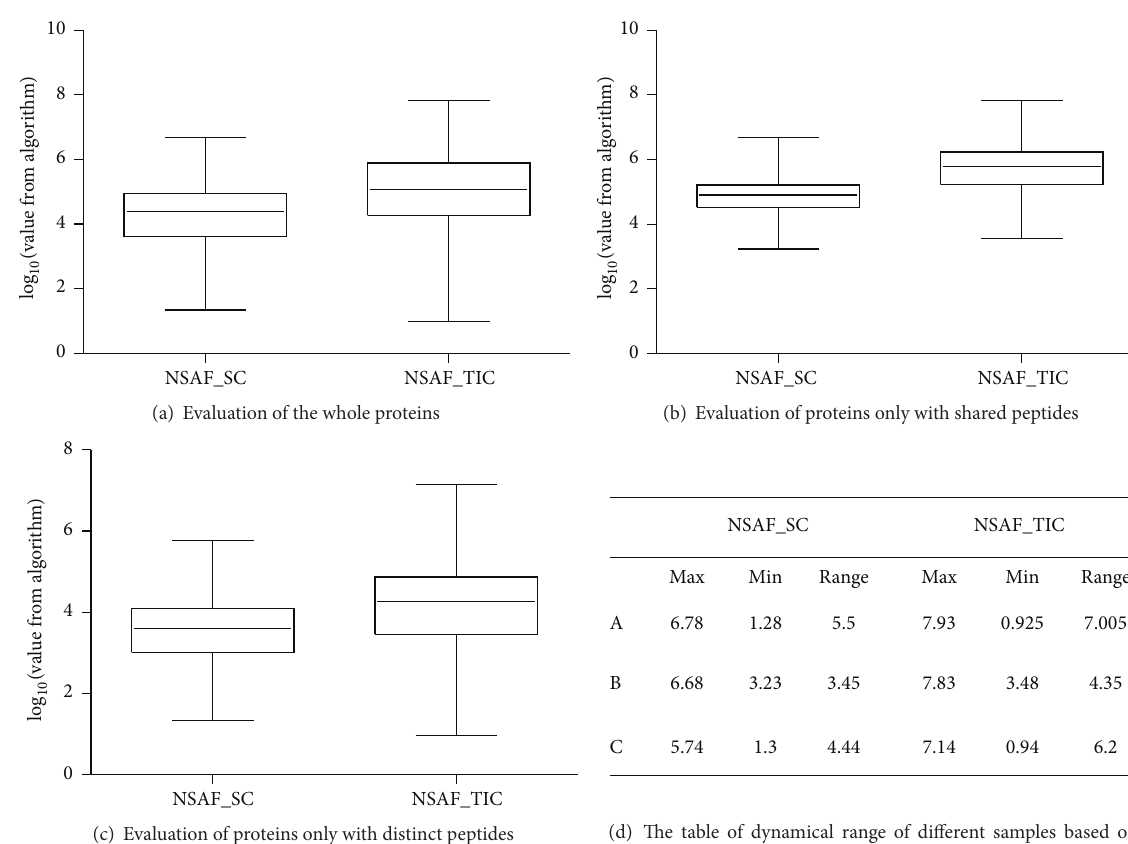
Figure 4: The protein abundance fold change of quantitative algorithm. Quantitative algorithms based on MS abundance features were involved. NSAF by spectral count and NSAF by total ion counts were used to quantify the whole protein dataset (a), proteins only with shared peptides (b), and proteins only with distinct peptides (c), respectively. It shows that the dynamical range of MS/MS TIC coupled with spectral count is broader than NSAF (d). Therefore, MS/MS TIC coupled with spectral count which alleviates this particular deficiency arising from SC was more suitable for determining protein abundance fold change. For panels (a), (b), and (c), the 𝑥 -axis represents the two quantitative algorithms, NSAF by spectral count (NSAF SC) and NSAF by TIC (NSAF TIC); the 𝑦 -axis represents the quantitative results of NSAF SC or NSAF TIC, which are calculated by Formula (1) and Formula (3) in Section 2.2, separately. The quantitative results are shown in log 10